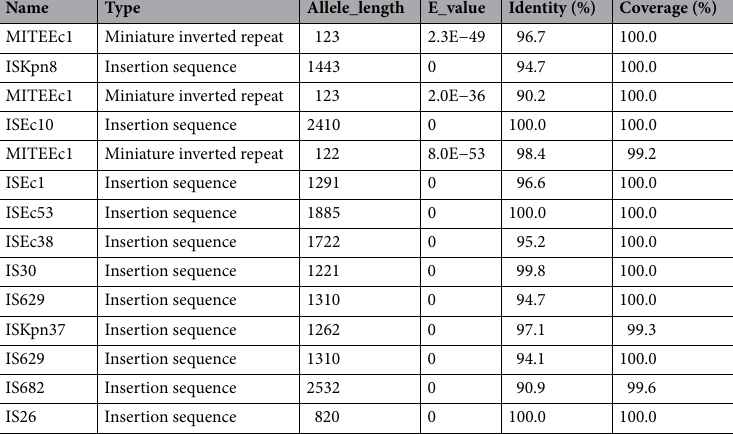
Table 4. Mobile genetic elements (MGEs) in the L16